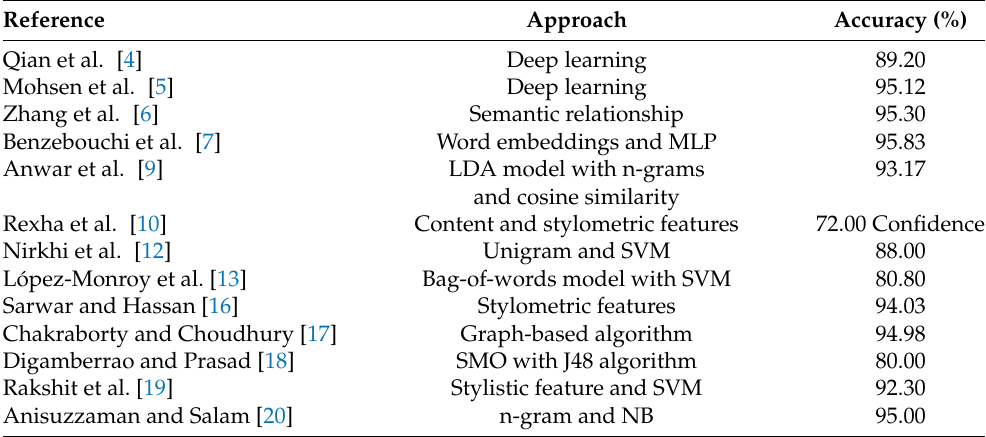
Table 1. The brief analysis of the literature